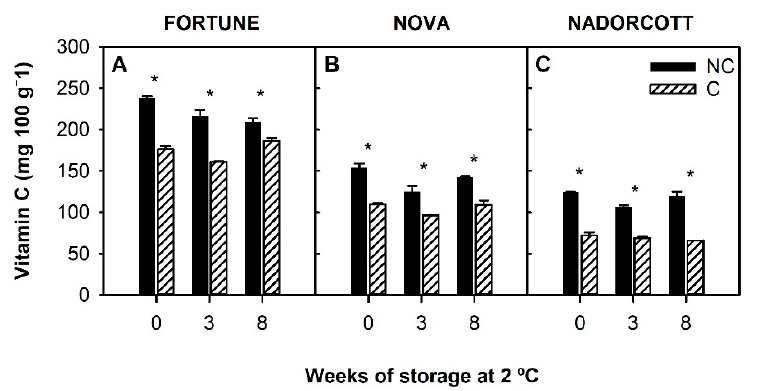
Figure 3. Total vitamin C content (mg 100 g − 1 ) at harvest (0) and during storage at 2 °C in the peel of non-covered (NC) and covered (C) fruit of Fortune ( A ), Nova ( B ), and Nadorcott ( C ). Asterisk indicates significant differences between NC and C fruit for each cultivar and sample date ( p ≤ 0.05, t- test).